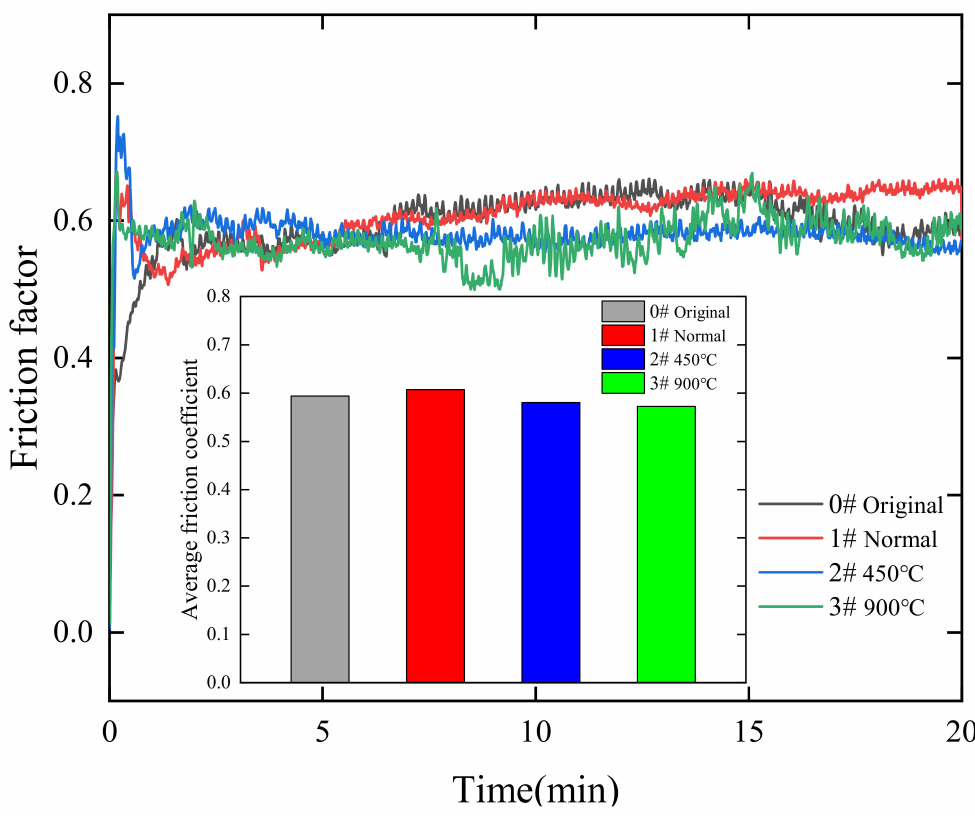
Figure 10. Changes in surface friction properties before and after laser